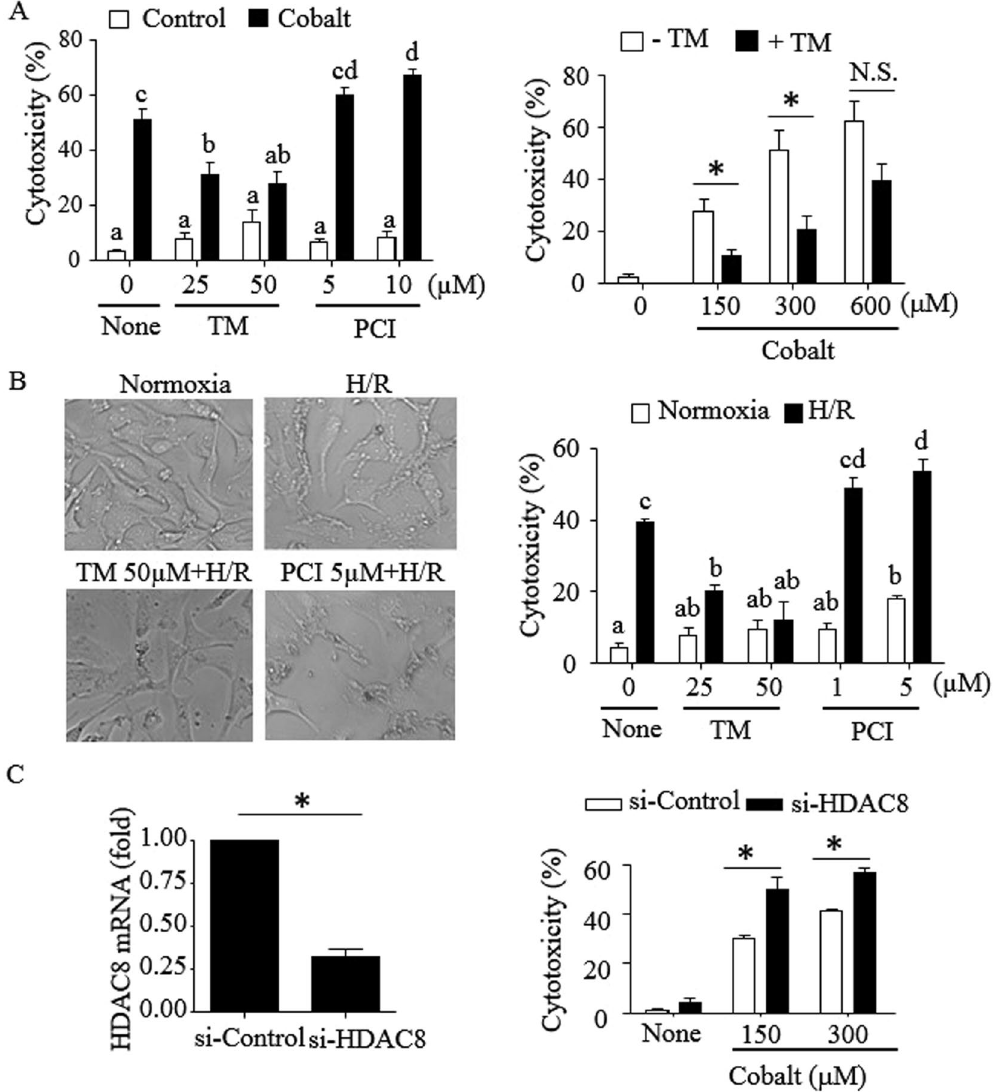
Figure 1. The HDAC8 activator TM-2-51 protects HK-2 cells from cytotoxicity induced by cobalt and hypoxia/ reoxygenation (H/R). ( A ) HK-2 cells were treated with cobalt (CoCl 2 ; 300 µ M) in the presence or absence of TM-2-51 (TM), the HDAC8 inhibitor PCI-34051 (PCI) and drug vehicle DMSO for 20–22 h (left panel). Similarly, cells were treated with varying doses of cobalt in the presence or absence of 25 µ M TM (right panel). ( B ) Cells were incubated in the hypoxia chamber (0.2% O 2 , 5% CO 2 & 95% N 2 at 37 °C) for 24 h, followed by a standard cell culture incubator (~21% O 2 , 5% CO 2 & ~74% N 2 at 37 °C) for the next 16–18 h. Cells were treated with or without TM (25 & 50 µ M) or PCI (1 & 5 µ M) throughout the experimental period. Cells were observed by microscopy using an Olympus microscope and images were acquired using QCapture Pro software at 20x magnification (left panel). ( C ) HK-2 cells transfected with control (scrambled) siRNA or HDAC8-specific siRNAs for 24 h were exposed to cobalt (300 µ M) for 16–20 h. HDAC8 siRNA was validated by real-time PCR analysis at 48 h post-transfection (left panel). ( A – C ) Cytotoxicity was measured by MTT assay as described in “ Methods ”. Results are from 3 independent experiments and data are expressed as mean ± S.D. For statistical analysis, Student’s t tests were performed on the data presented in A right and C panels ( * p < 0.05; N.S., not significant), and one-way ANOVA with Tukey multiple comparison tests were performed on data presented in A left and B right panels (p < 0.05; columns accompanied by the same letter are not significantly different from each Inhibition of DRP1 protects HK-2 cells from mitochondrial dysfunction and fission, and cyto- toxicity. Since expression of DRP1 was induced by cobalt and H/R (Fig. 4), the role of DRP1 in mitochondrial fission and cell viability in HK-2 cells was further examined. First, we examined the effect of the DRP1 inhibi- tor Mdivi-1 26 on cytotoxicity and mitochondrial fission. Mdivi-1 at 10 µ M significantly prevented cytotoxicity (Fig. 5A) and mitochondrial fission (Fig. 5B) in cells exposed to cobalt and H/R. Similarly, Mdivi-1 prevented cytotoxicity and mitochondrial fission in rat renal proximal tubular NRK-52E cells (Supplemental Fig. S2).